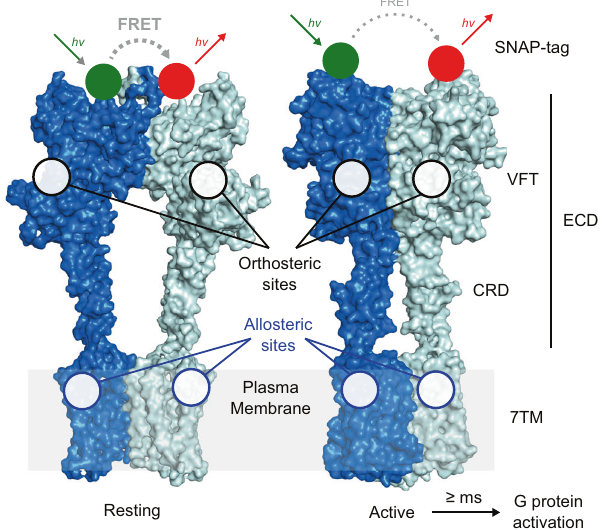
Fig. 1 Structure and conformational rearrangements of mGlu receptor. Structures of dimeric mGlu2 in resting and active conformations. The major structural elements of each subunit include the extracellular domain (ECD, comprising the Venus fl y-trap domain (VFT) and the cysteine-rich domain (CRD)) and the seven-transmembrane domain (7TM). Orthosteric ligand binding sites are found in the cleft between the upper and lower lobes (black circles) of the VFT and the majority of allosteric modulators bind to sites in the 7TM (blue circles). Activation leads to a closure of the VFTs and a reorientation of the ECDs, the CRDs, and the 7TMs bringing the two subunits into closer proximity. In N-terminally SNAP-tag labeled receptor dimers this leads to a transition from a high FRET/resting to a low FRET/ active state. G protein activation through interactions with the cytoplasmic side of the 7TM is reported to occur at >10 ms timescales. The shown structures were generated using PDB ID 7EPA and